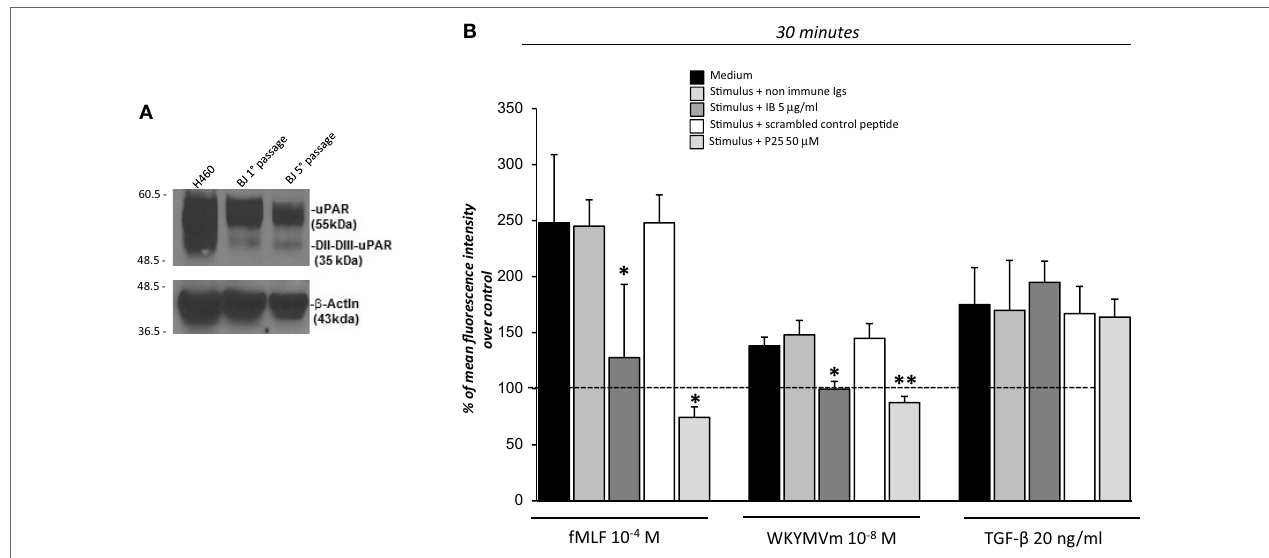
FigUre 3 | Effects of the inhibition of the cross-talk between FPRs-uPAR-Integrins on reactive oxygen species (ROS) induction in BJ cells. (a) Western blot analysis of uPAR expression in H460 cell line as a positive control (lane 1), BJ cells at first passage (lane 2) and fifth passage (lane 3) in culture with the R4 anti-uPAR mAb and with an anti- β -actin Ab, as a loading control. (B) BJ cells were plated in a 96-well plate and treated with DCHF-DA. At the end of incubation, cells were treated with medium alone, N -formyl- l -methionyl- l -leucyl- l -phenylalanine (fMLF), WKYMVm or TGF- β in the absence (black columns) or in the presence of nonimmune immunoglobulins (medium gray columns), IB antibody (dark gray columns), scrambled control peptide (Scp) (white columns), and P25 peptide (light gray columns). ROS release was measured as dichlorofluorescein (DCF) fluorescence at 30 min. Results are expressed as a percentage of increase of mean fluorescence intensity of stimulated DCHF-DA-loaded cells in respect to unstimulated DCHF-DA-loaded cells (considered as 100%). Values are the mean ± SEM of three experiments performed in triplicate. * p < 0.05; ** p <